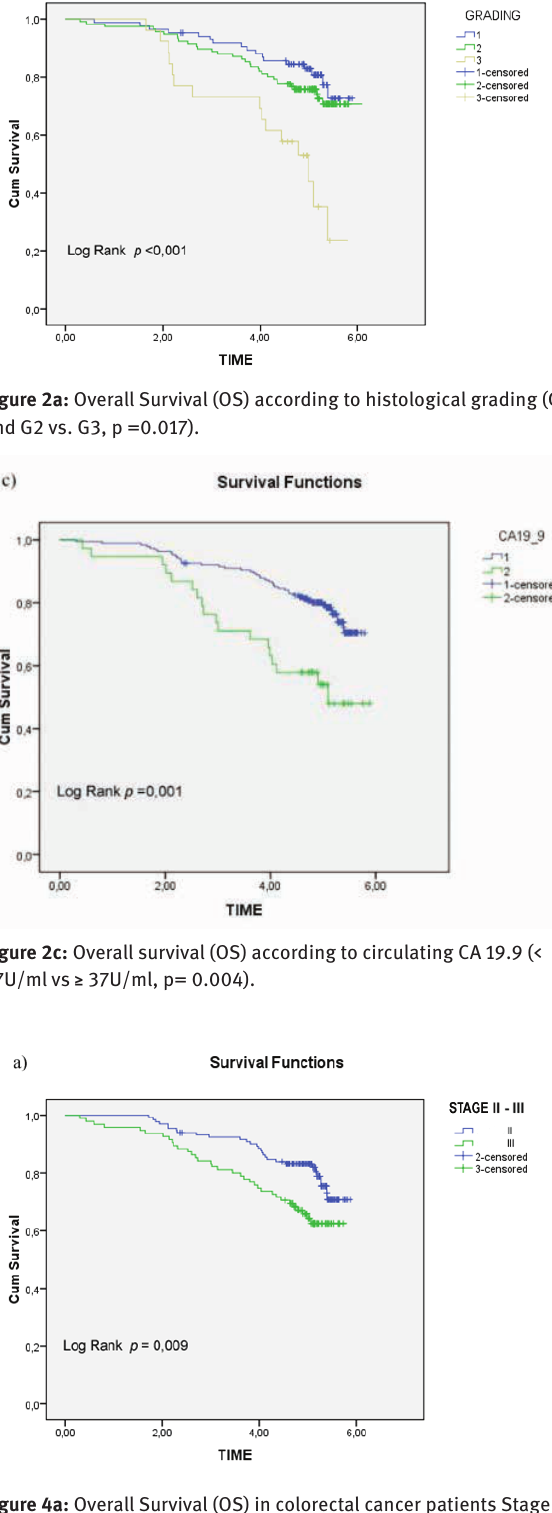
Figure 4a: Overall Survival (OS) in colorectal cancer patients Stage II and III ( p <0.05);